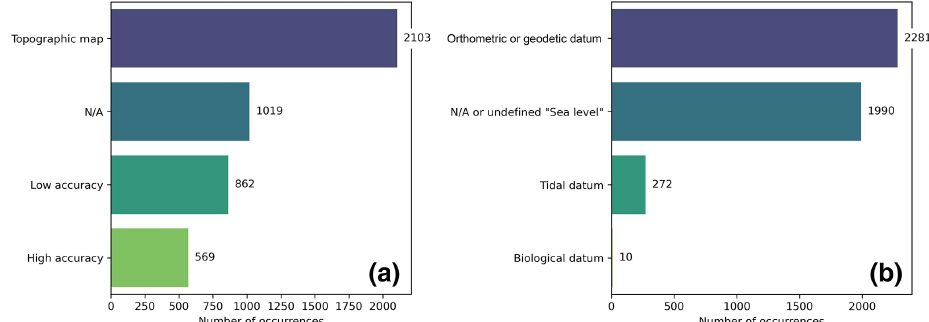
Figure 9. Elevation measurement methods (a) and vertical datums (b) associated with sea-level proxies in WALIS. The code used to create this image is available from Rovere et al. (2022).